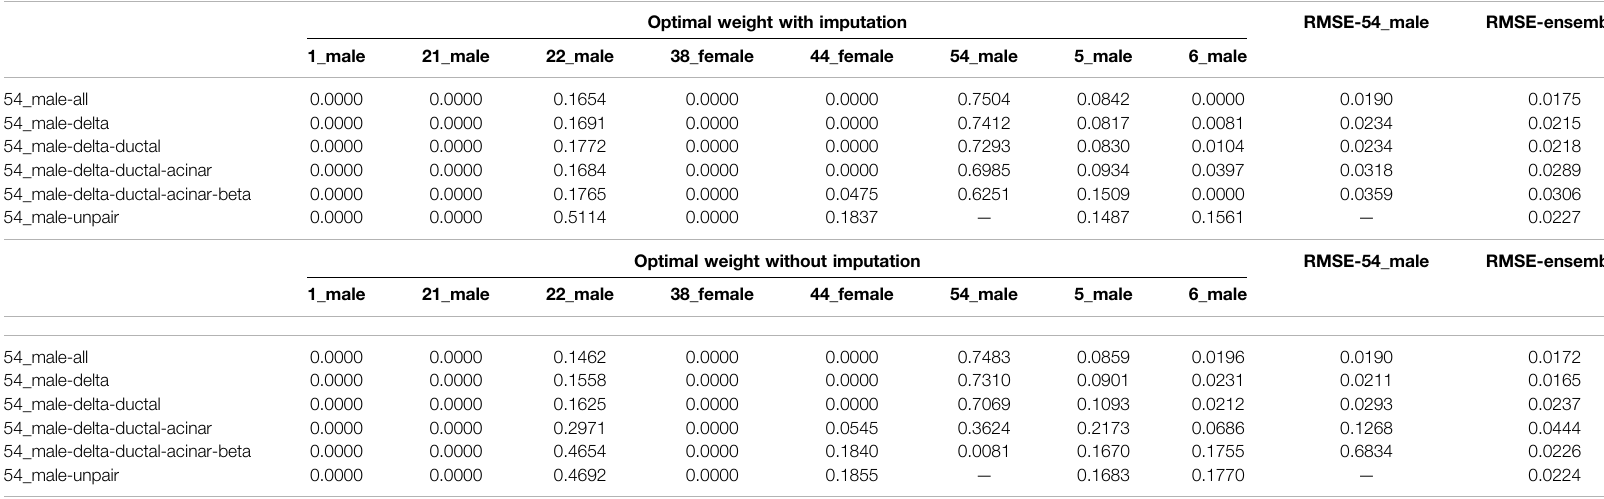
TABLE 2 | Optimal weights of different individual references under the DecOT ensemble framework. The weights and the overall performance are compared under different settings of the missing cell type in the paired reference of sample 54_male. Imputation indicates that the reference pro fi les of missing types are imputed by references from other